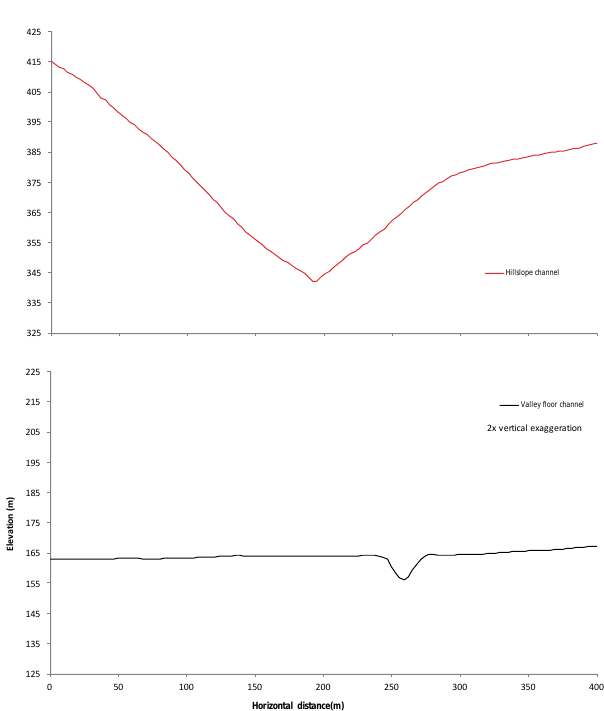
Figure 2. Typical topographic cross sections of a valley floor chan- nel and hillslope channel from the Tassajara Creek tributary.